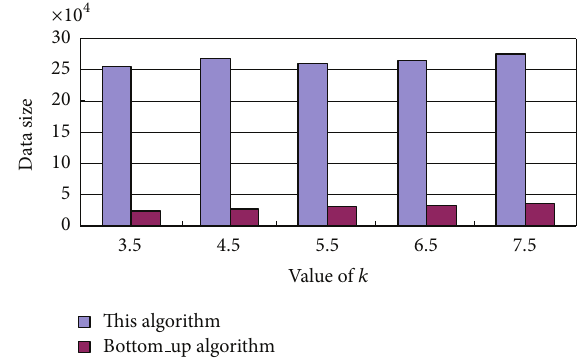
Figure 6: Size of processed anonymous data for our algorithm and the Bottom up